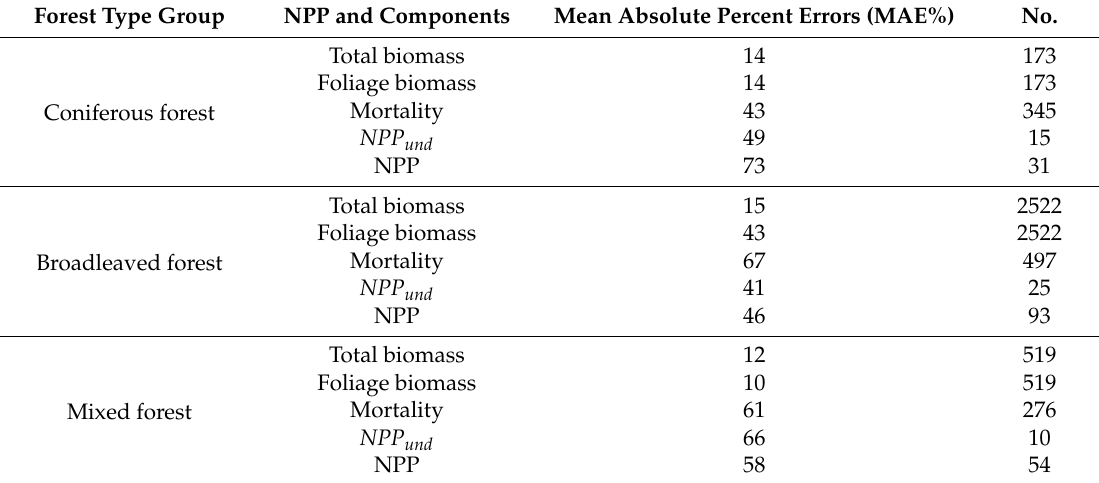
Table 7. The Mean absolute percent errors (MAE%) of NPP and several components for the three main forest type